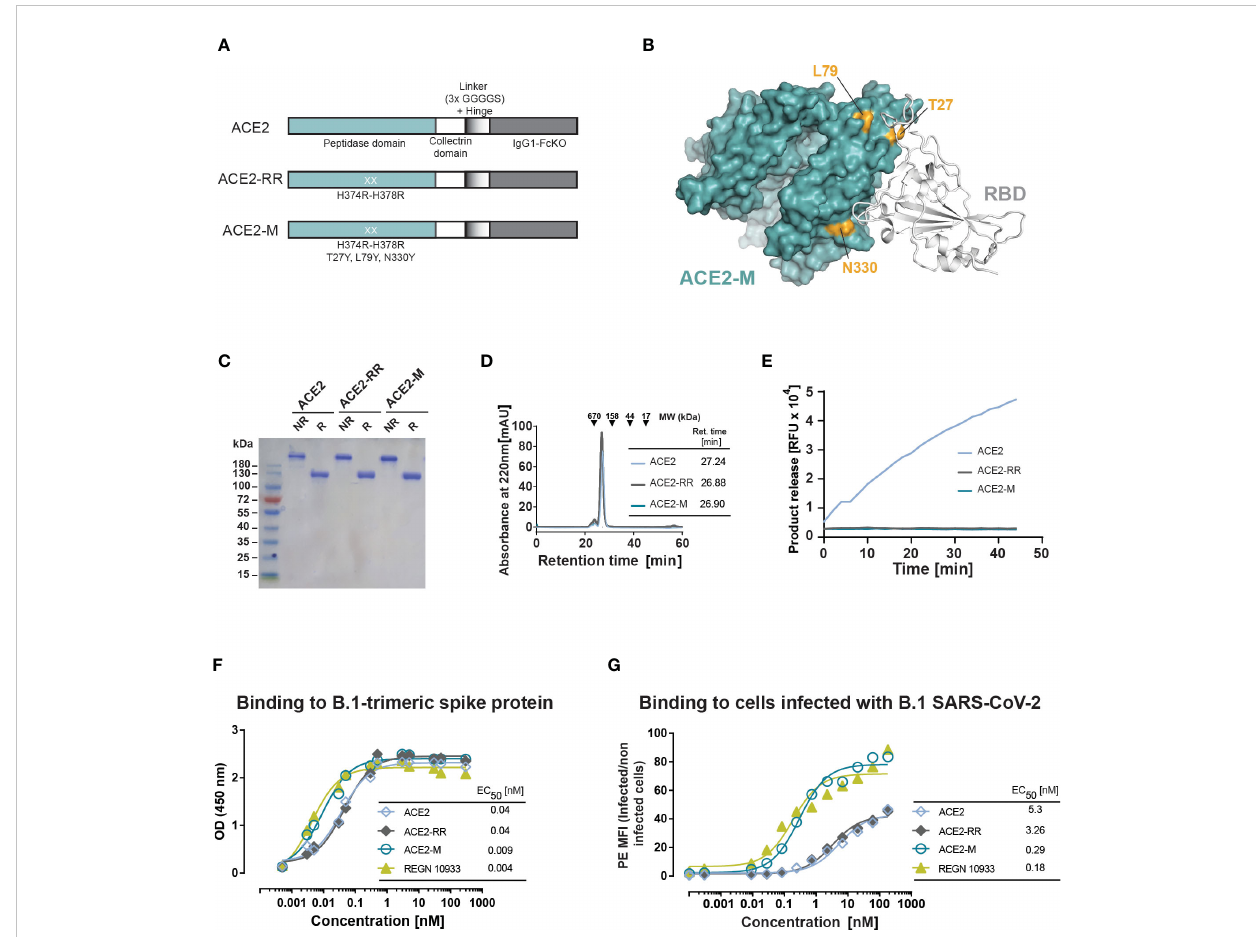
FIGURE 1 Design and biochemical characterization of ACE2-M. (A) Schematic representation of the ACE2 molecules used in this study. The ACE2 extracellular domain, comprising peptidase and collectrin domains, was fused to an IgG1-Hinge-Fc-Ko domain via a fl exible linker (GGGGS)3 (ACE2 version). The H374R-H378R mutations were introduced to abolish ACE2 enzymatic activity (ACE2-RR version). Additional mutations were introduced to increase binding to the S-protein as indicated in (A, B) . (B) Structure of ACE2 in complex with S-RBD (using PDB 6M0J) with residues substituted in ACE2-M highlighted in gold. (C) Coomassie-stained gel of the three generated fusion proteins. NR, non-reduced; R, reduced. (D) Superposed analytic chromatography pro fi les of the ACE2 proteins run on a Superdex S200 Increase 10/300GL column. The table indicates the corresponding retention times. (E) Enzymatic activity of the ACE2 fusion proteins (4.5 nM) as measured by cleavage of a fl uorescent peptide substrate. (F) Binding of the fusion proteins and REGN 10933 to B.1 trimeric S-protein determined by ELISA. Results represent the standard deviation (SD) of n=3. EC 50 as calculated by the GraphPad software. (G) Binding of the fusion proteins and REGN 10933 to Caco-2 cells infected with the recombinant infectious clone SARS-CoV-2 that expresses the mNeonGreen as a reporter gene. Binding was assessed by fl ow